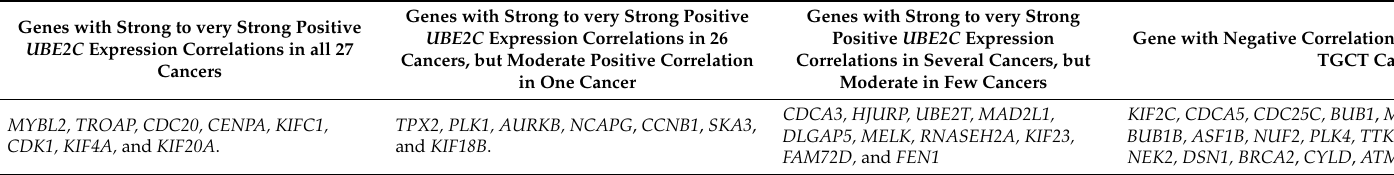
Table 2. Expression correlation between UBE2C and various